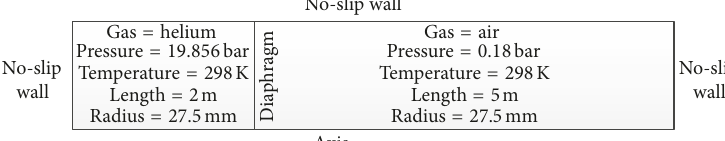
Figure 2: Computational domain and its boundary conditions.